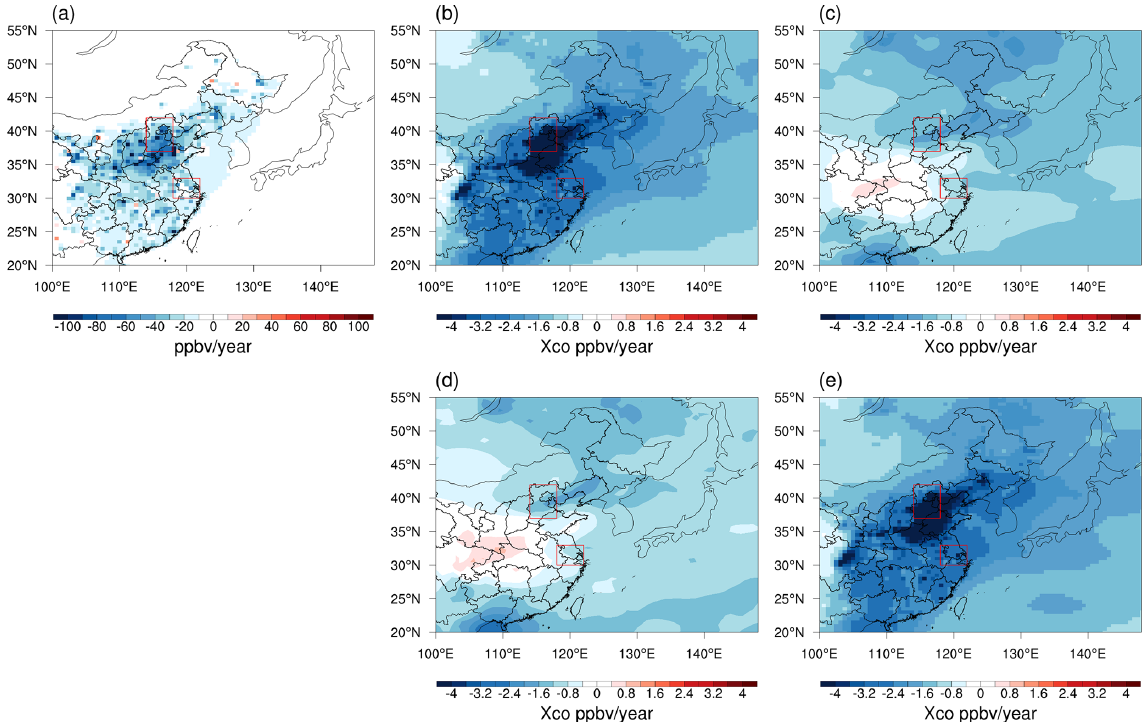
Figure 5. Trends of surface CO concentrations in 2015–2020 by assimilating (a) raw MEE CO and trends of CO columns in 2015–2020 by assimilating (b) normalized MEE CO, (c) MOPITT CO column data, (d) MOPITT CO profile data and (e) normalized MEE CO + MOPITT CO column